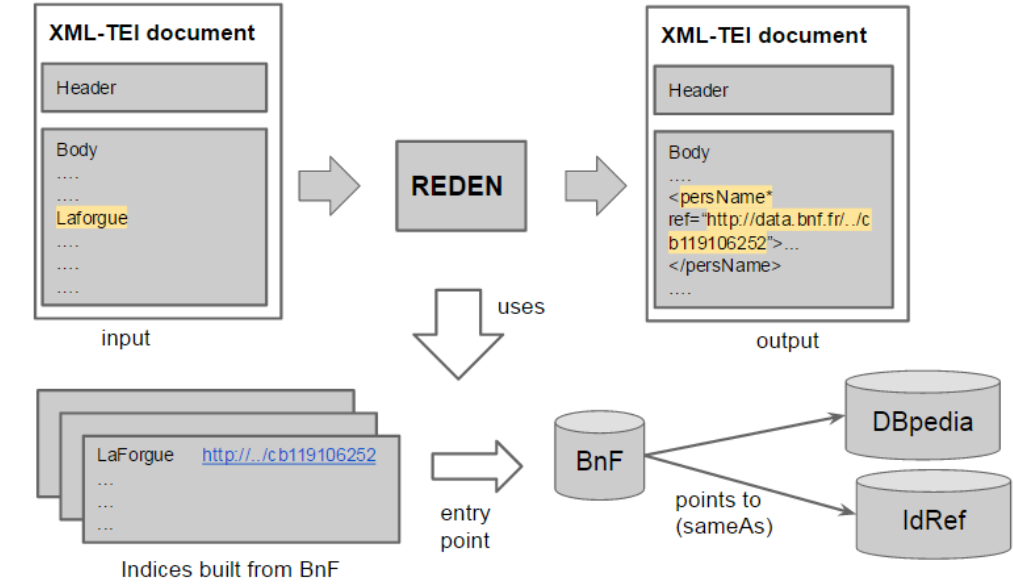
Figure 5. REDEN general work-flow adapted to the example in Subsection